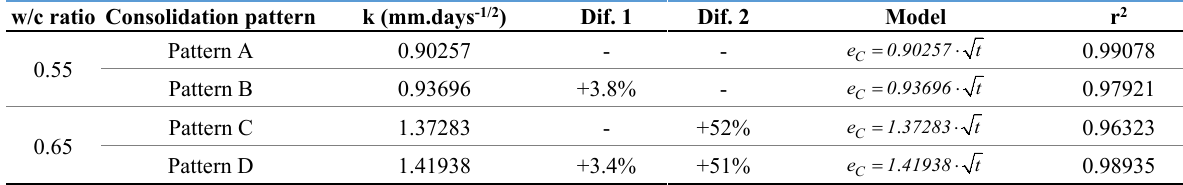
Table 6. Diffusion coefficients obtained for each mixture and consolidation condition analyzed.